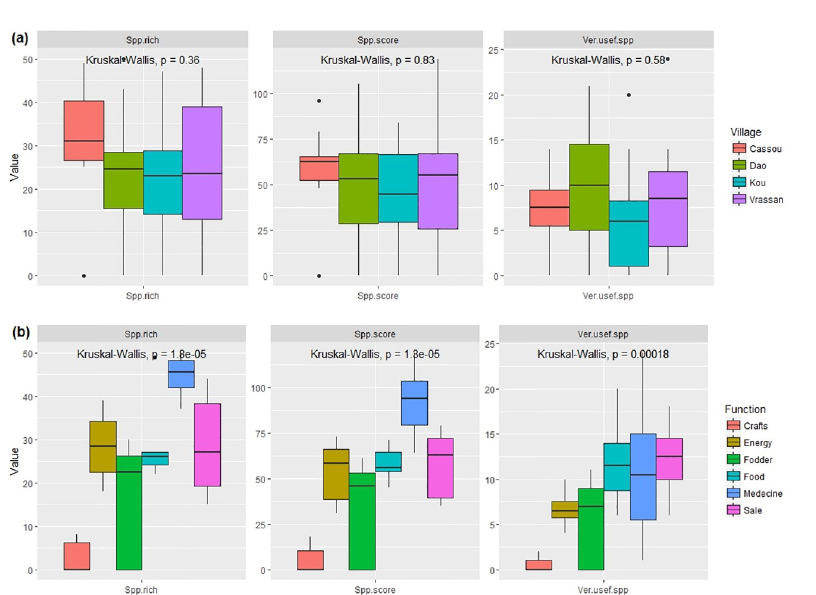
Fig 3. Abundance of very useful tree species, species richness and total score of tree function in Ziro province of Burkina Faso per (a) pilot village (Cassou, Dao, Kou and Vrassan) and (b) per tree function. Spp.rich = species richness; Spp.score = total score of tree function; Ver.usef.spp = very useful tree species.